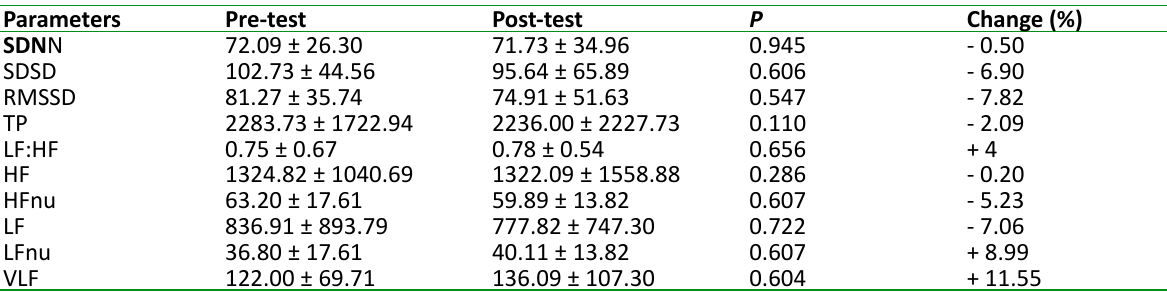
Table 3. HRV results of the control